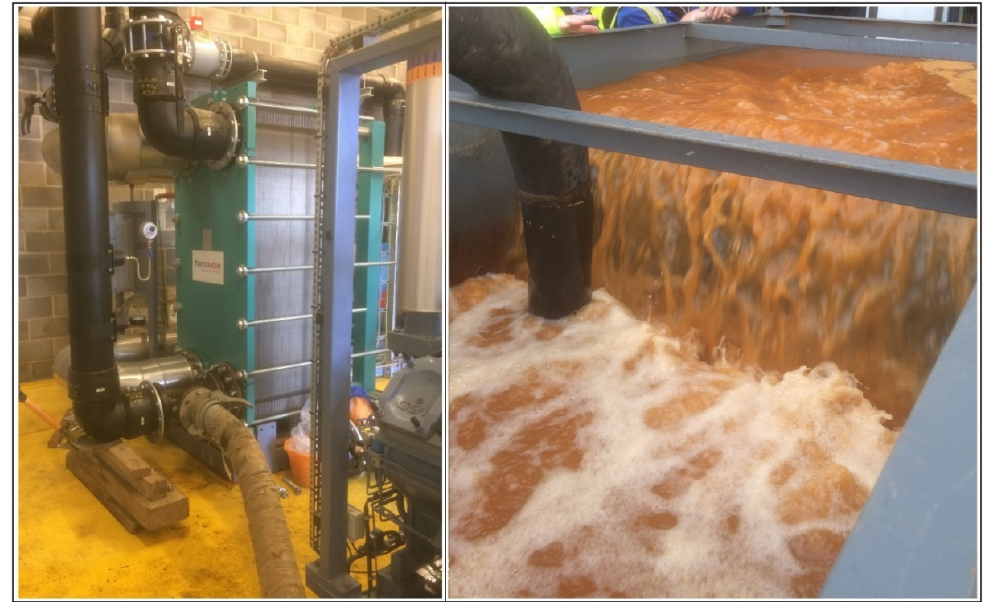
Figure 6. Recirculation of citric acid solution through the plate heat exchanger at Abbotsford Road, ( left ), to remove accumulated ochre (which can be seen in the recirculation tank, ( right ). Photos reproduced with permission of © David Banks, after [2,36].